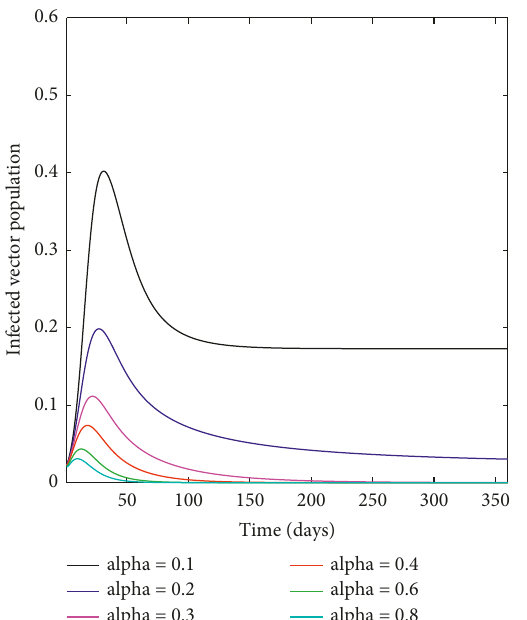
Figure 9: c � 0 . 2 for the infected vectors. Figure 11: Increasing recovery rate with α � 0.2.